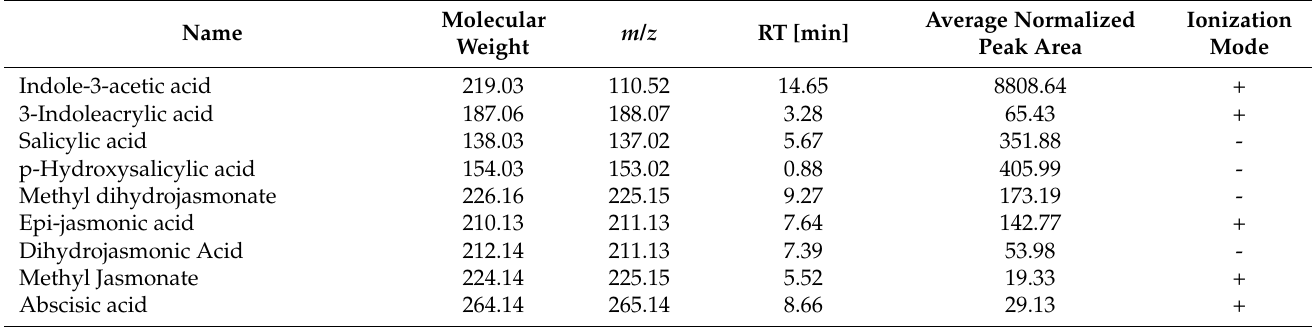
Table 2. Phytohormones detected in M. rhizosphaerae NFX-FRZ